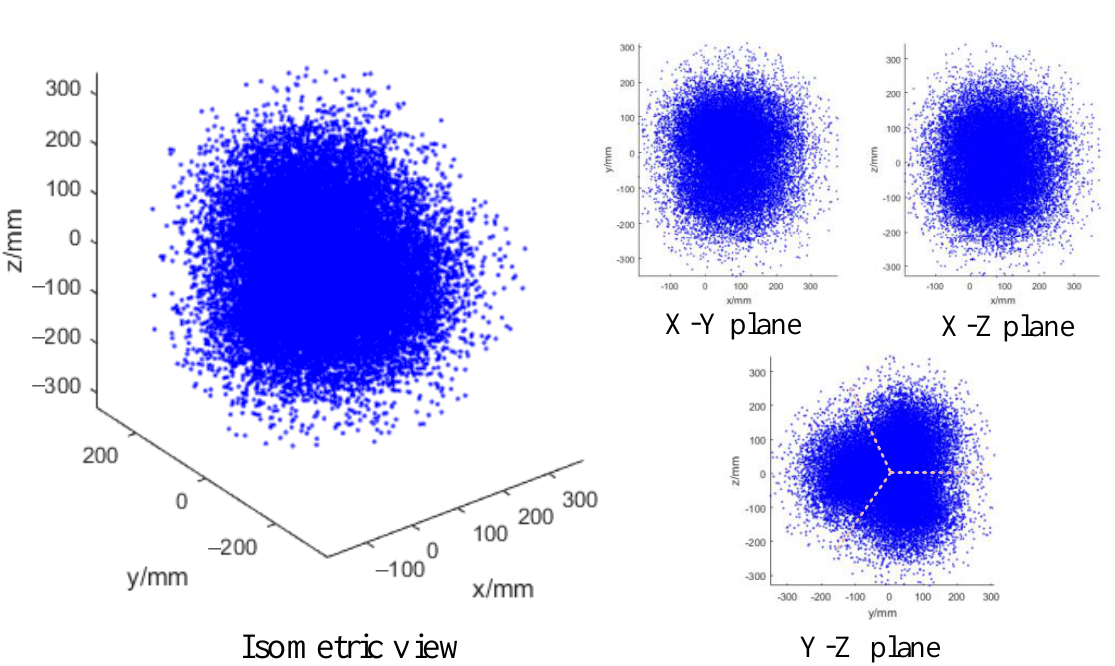
Figure 10. Working space of the triple-arm space robot (the pink dash lines shown in Y–Z plane are to demonstrate the symmetrically distributed working spaces of the three operating arms.).